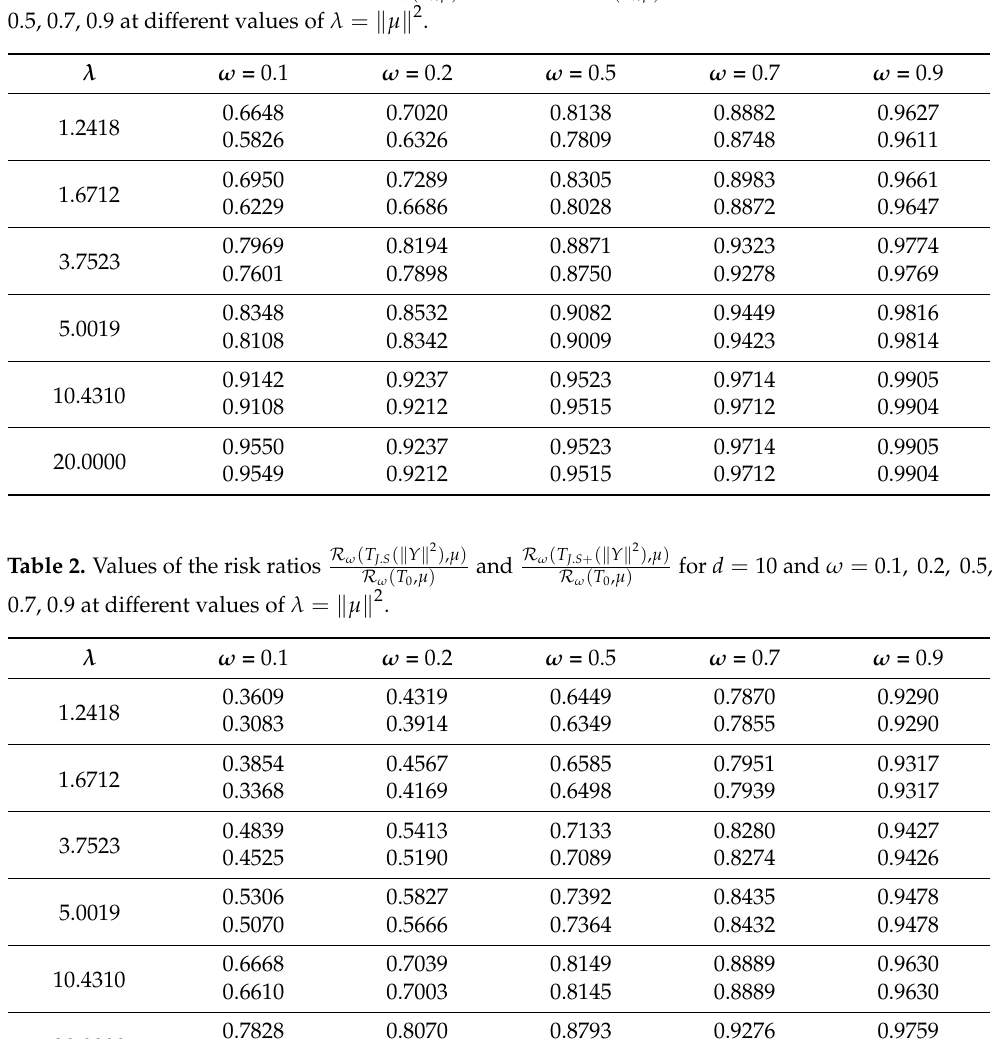
Table 1. Values of the risk ratios